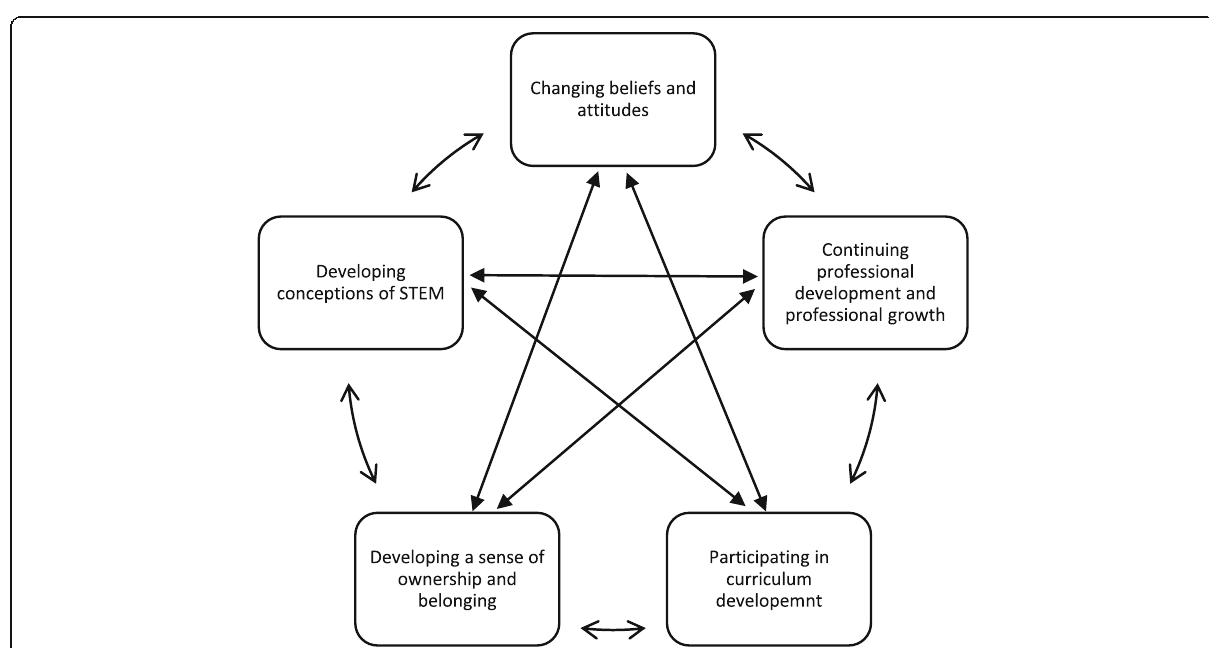
Fig. 2 The dialogical relationship between the different aspects of the evolution of STEM teachers ’